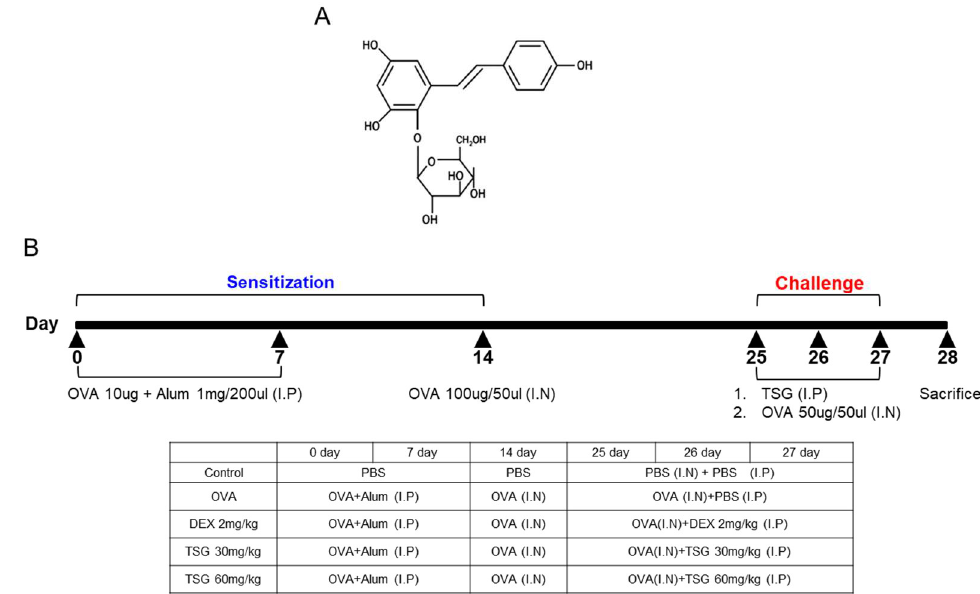
Figure 8. ( A ) Structure of 2,3,5,4’-tetrahydroxystilbene-2-O-β- D -glucoside (TSG) and ( B ) experimental protocol for induction of airway inflammation along with treatment scheme.